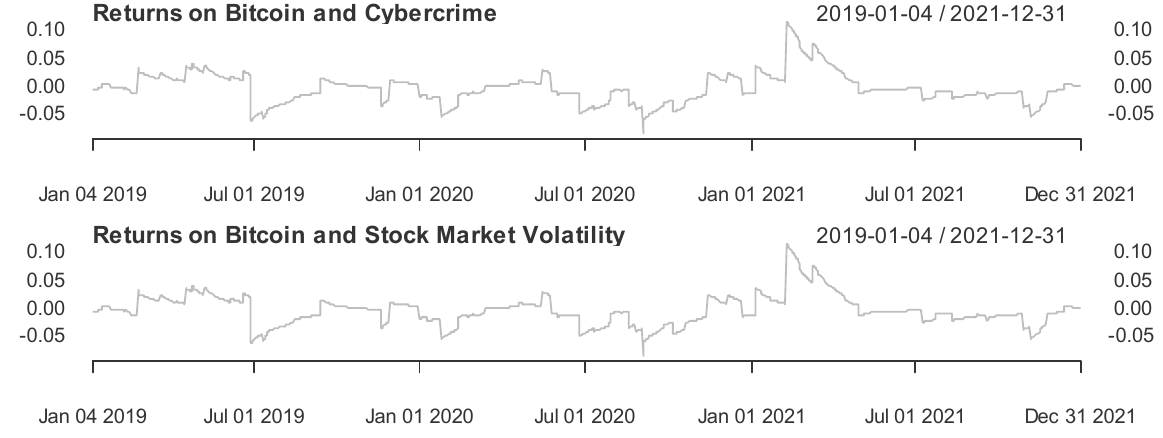
Figure 4. Time‑varying correlation coefficients between returns on Bitcoin and cybercrime and stock market volatility.